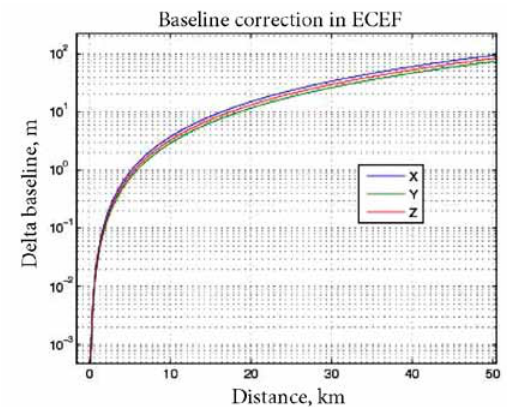
Fig. 2. Illustration of the impact of the first hypothesis (saying that the paths of propagation between the satellite and the two antennas are parallel. The Y semi-log axis represents the error introduced in the baseline because of this hypothesis. The scenario at stake here is: a rover gets away equally in each direction (X, Y, Z) from the master. We can see that this hypothesis is true up to a certain distance, depending on the wanted